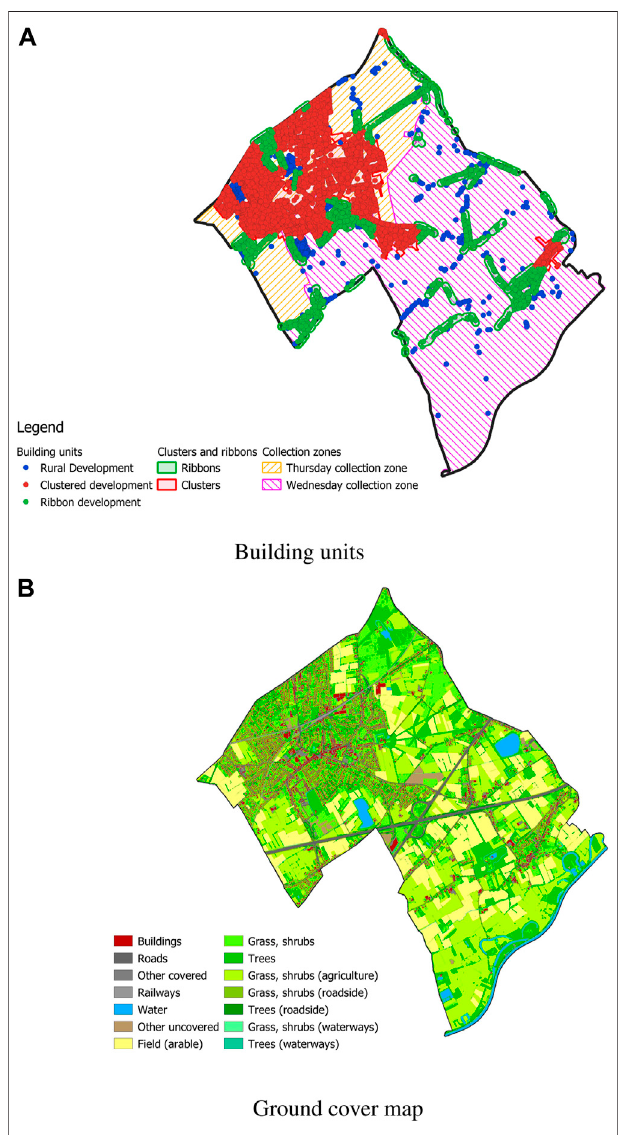
FIGURE 14 | Building units with the two collection rounds and ground covermapofthecasestudyregion. (A) Buildingunits, (B) GroundCovermap.